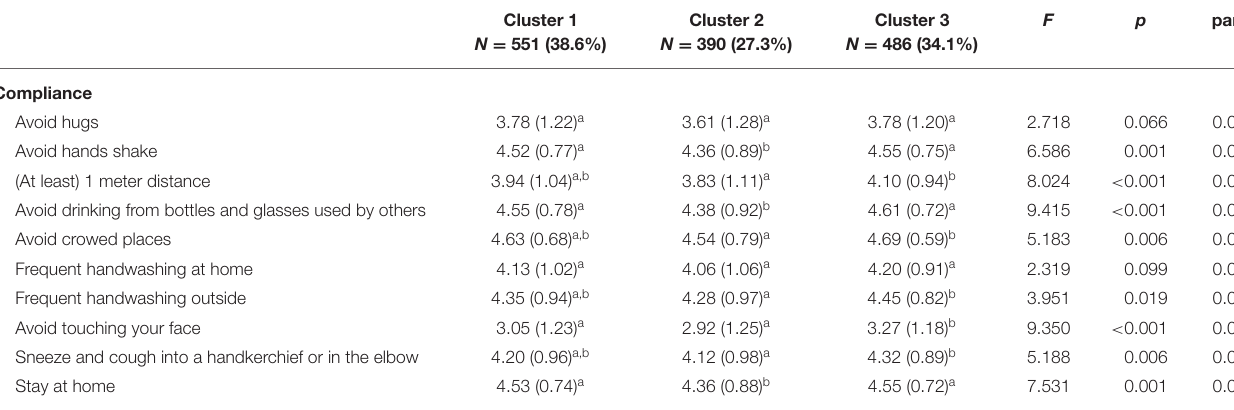
TABLE 4 | Between group comparison